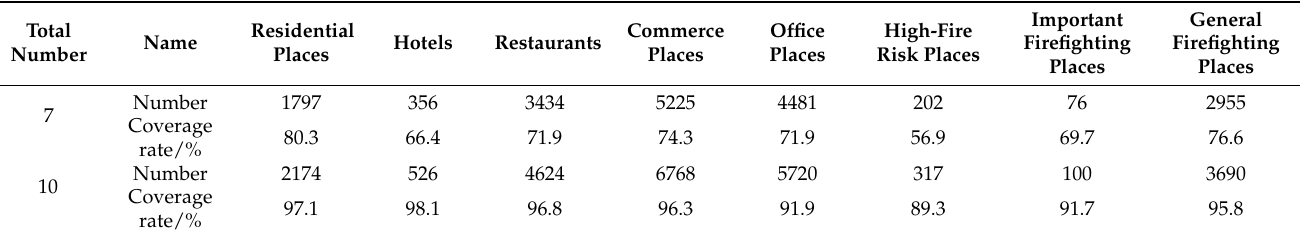
Table 6. The number of POIs in different places covered by fire stations before and after